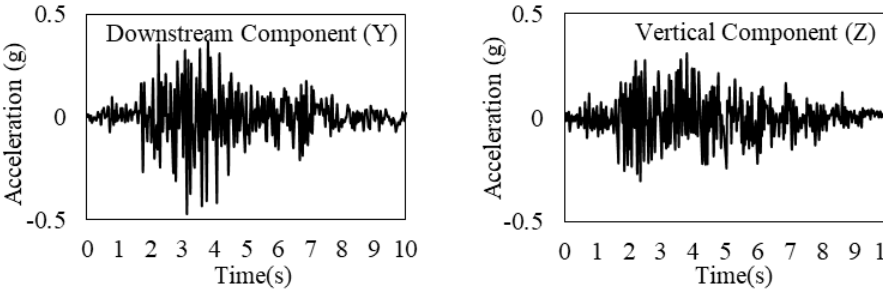
Figure 8. The Koyna earthquake acceleration time–history (g).